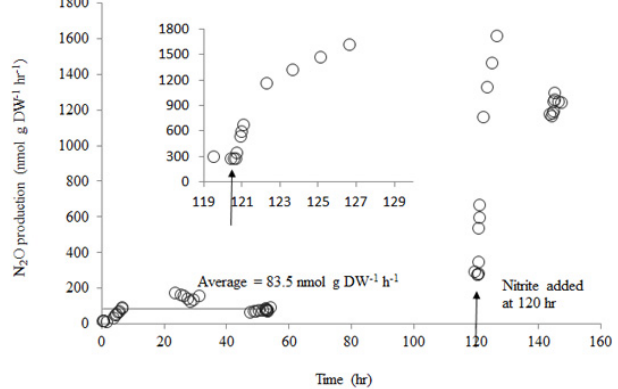
Fig. 3. Changes in N 2 O specific production rate (nmolg DW − 1 h − 1 ) in a 4L column photobioreactor. Illumination was turned off at t = 0 and NaNO 2 (1.38g) was added after 120h of monitoring. The concentration of algae was 1.26–1.56gL − 1